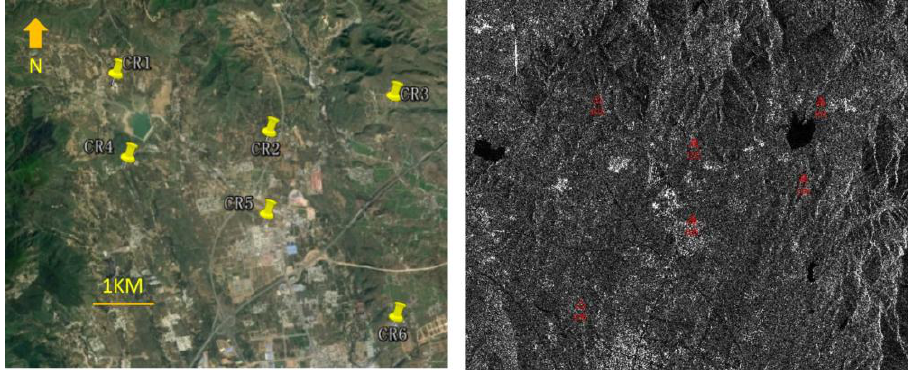
Figure 7. Distribution of six corner reflectors (CR) in the Google Earth ( left ) and Data B image ( right ). Table 5. Geometric calibration parameters of Gaofen-3 solved by conventional field calibration.